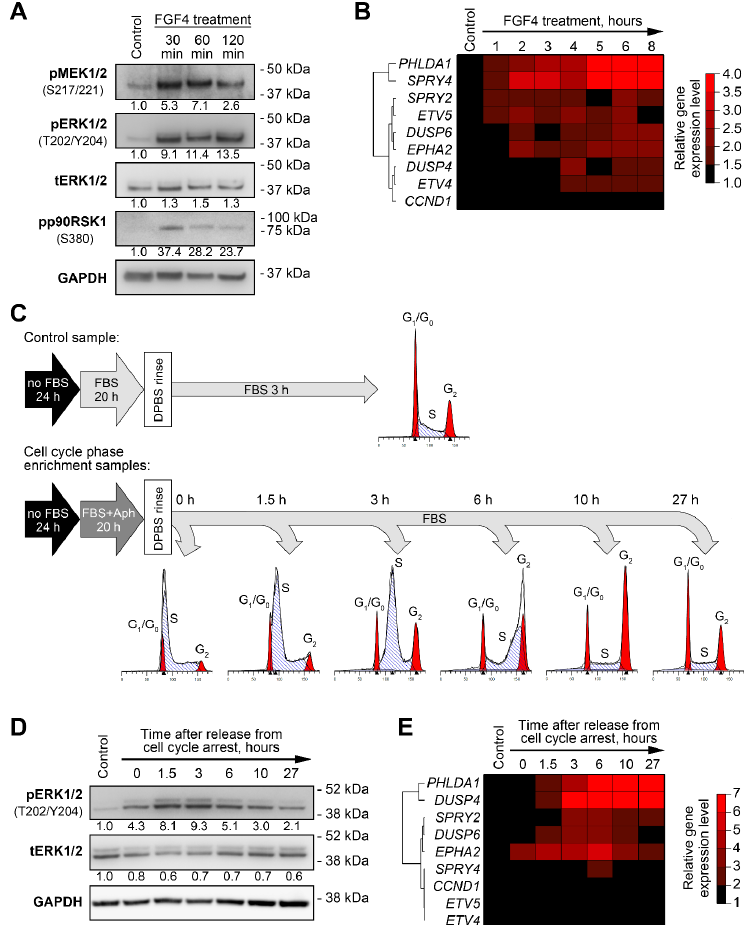
Figure 1. Changes in expression levels of MPAS genes induced by MEK/ERK pathway activity modulation in PEO4 cells. ( A ) Immunoblotting analysis of phosphorylation of MEK/ERK pathway components in response to treatment with FGF4 (100 ng/mL). Numbers under the bands represent relative intensity normalized to GAPDH levels and control samples. ( B ) Changes in expression of MPAS genes in FGF4-treated cells. Heatmap represents gene expression levels normalized to control samples. Unsupervised hierarchical clustering was performed using 1-minus Spearman’s rank correlation metrics. ( C ) Experimental design for enrichment of cultured cells in different phases of cell cycle (see Methods for details). Aph—aphidicolin. ( D ) Immunoblotting analysis of ERK1/2 phosphorylation changes during cell cycle progression in synchronized cells. Numbers under the bands represent relative intensity normalized to GAPDH levels and control samples. ( E ) Changes in expression of MPAS genes during cell cycle progression. Heatmap represents gene expression levels normalized to control samples. Unsupervised hierarchical clustering was performed using 1-minus Spearman’s rank correlation